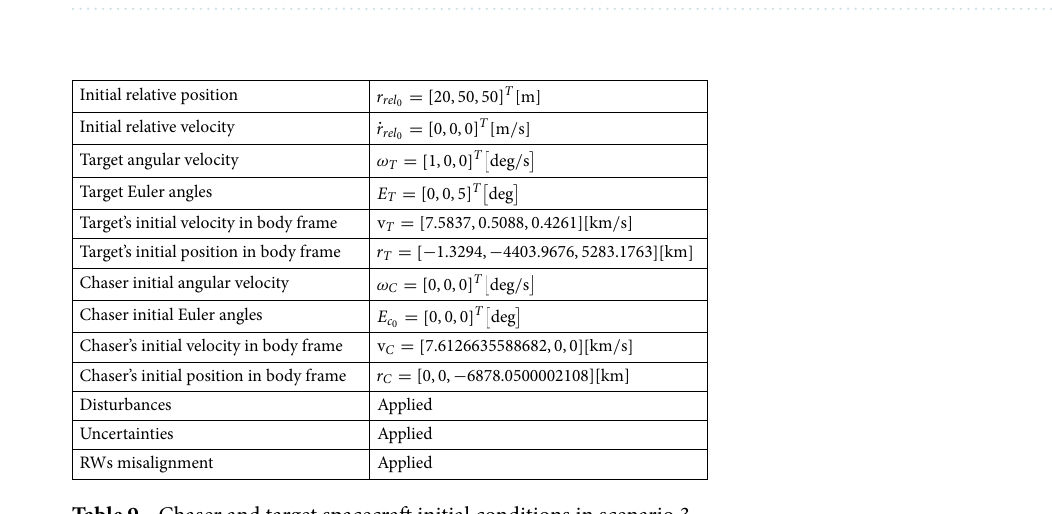
Figure 51. Relative pose trajectory in polar coordinate (Scenario 2).